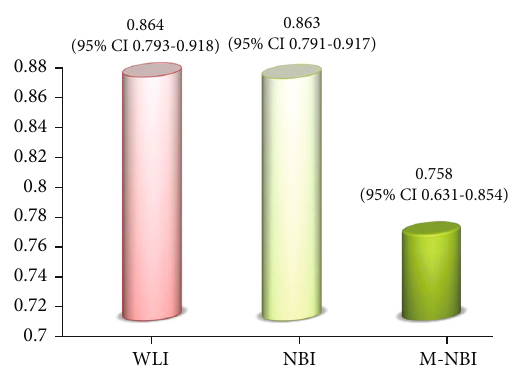
Figure 5: Intraclass correlation between observers. NBI: narrow- band imaging; WLI: white-light